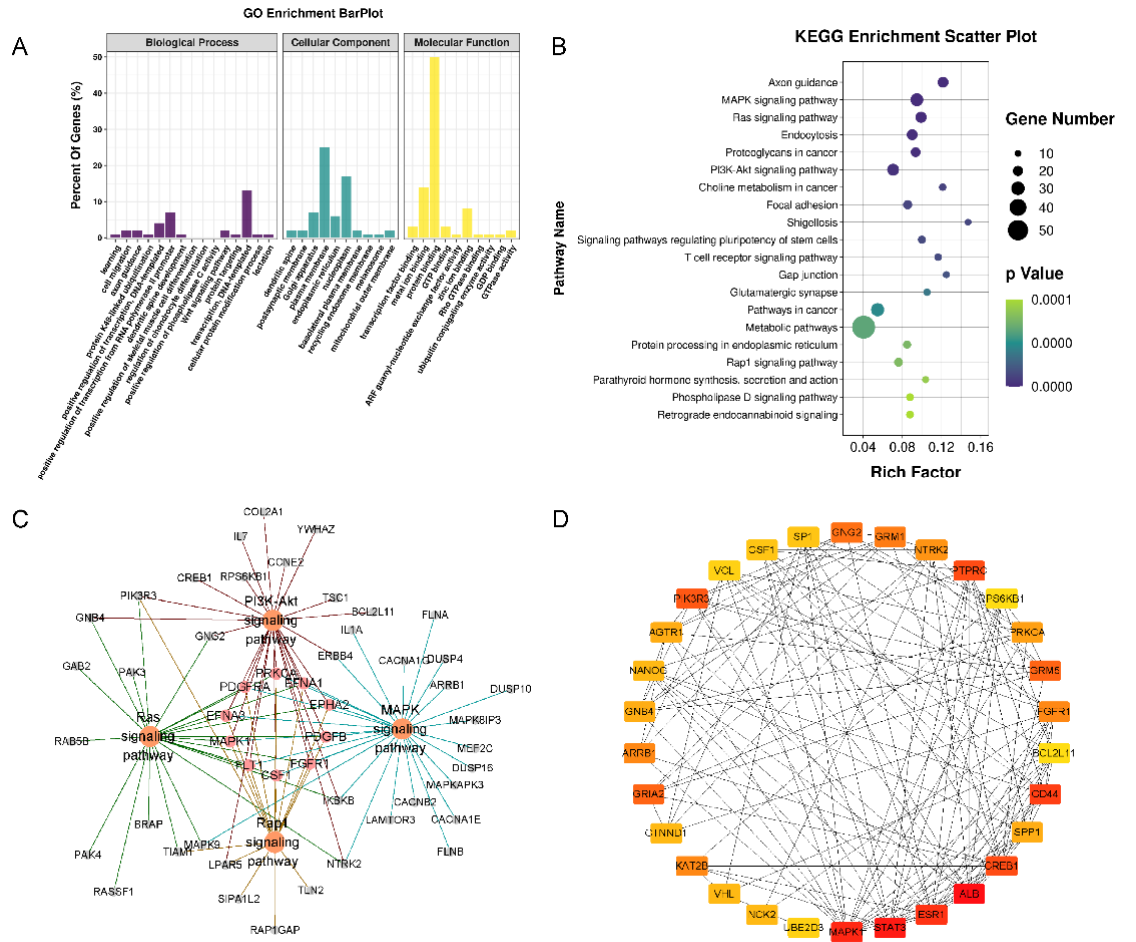
Figure 5. Functional enrichment analysis of the target genes of 4 miRNAs. ( A ) GO pathway enrich- ment analysis of the target genes of 4 miRNAs. ( B ) KEGG pathway enrichment analysis of the target genes of 4 miRNAs. ( C ) The target-gene regulatory network of MAPK, RAS, PI3K-Akt, and Rap1 signaling pathways. ( D ) The PPI networks of the top 30 hub target genes. ALB, STAT3, and MAPK1 exhibited the highest node degrees (62, 58, and 54, respectively).